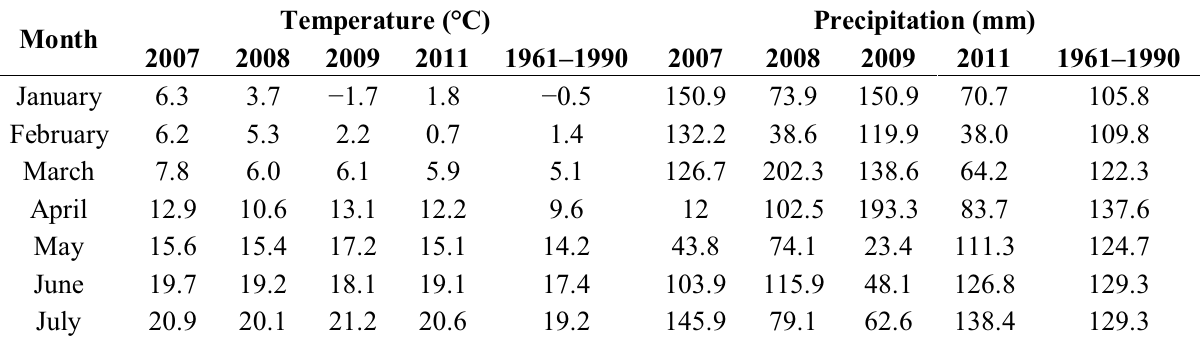
Table 3. Mean monthly temperature and precipitation data during the growing season at Ogulin, Croatia, in 2007 (cid:177) 2009 and 2011 (data obtained from the CDA device) compared with the long-term average